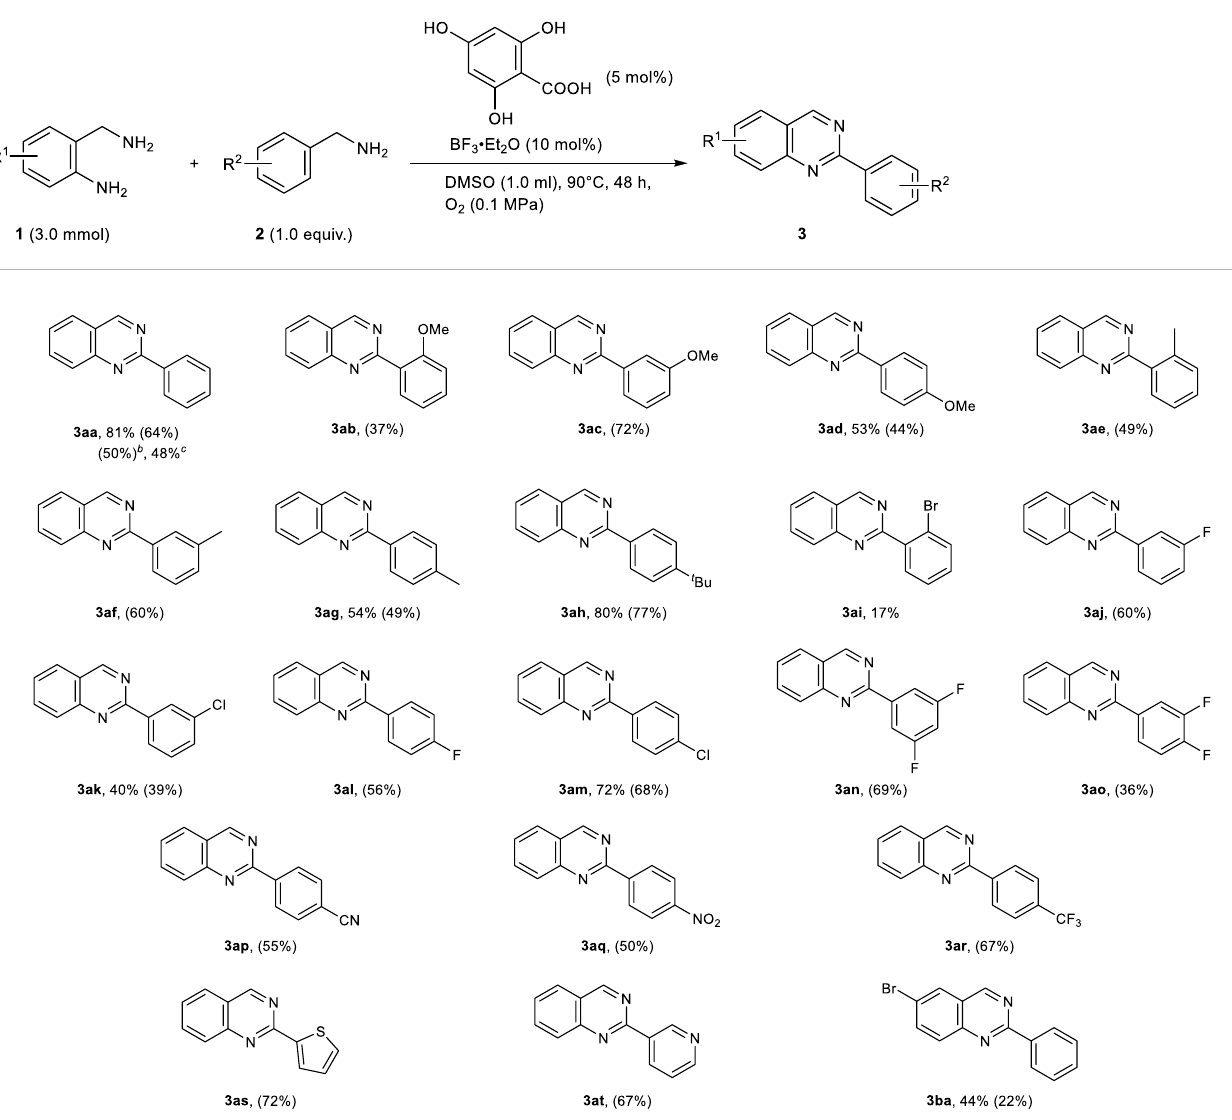
TABLE 2 | Reaction scope for the metal-free/oxidative synthesis of 2-substituted quinazolines.